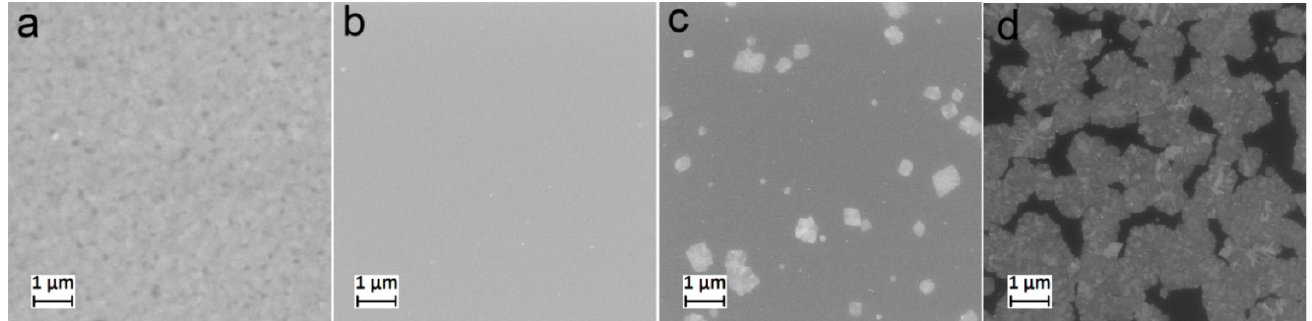
Figure 2. SEM images of TiO 2 coatings deposited on the silicon using 800 ALD cycles TTIP/H 2 O at 250 ° С ( a ), 400 ALD cycles TTIP/O 2 plasma at 250 ° С ( b ), 500 ALD cycles TTIP/O 2 plasma at 270 ° С ( c ), and 500 ALD cycles TTIP/O 2 plasma at 300 ° С ( d ).